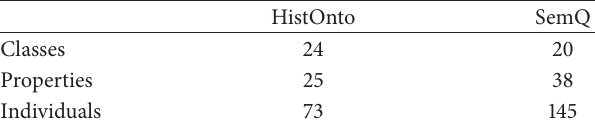
Table 2: Ontology statistics.